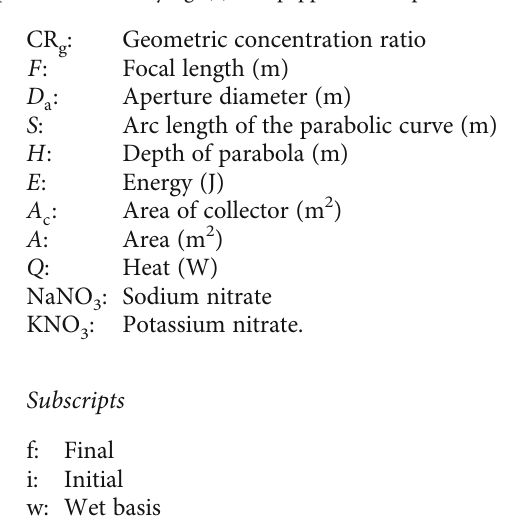
Figure 13: (a) Fresh red peppers before drying. (b) Red peppers after solar drying. (c) Red peppers after open sun